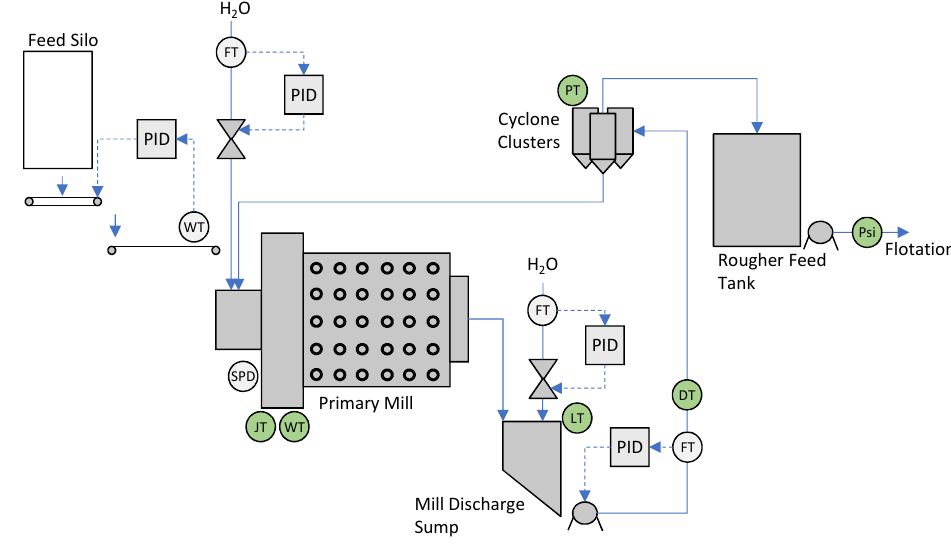
Figure 3. Simplified process flow diagram of the primary milling